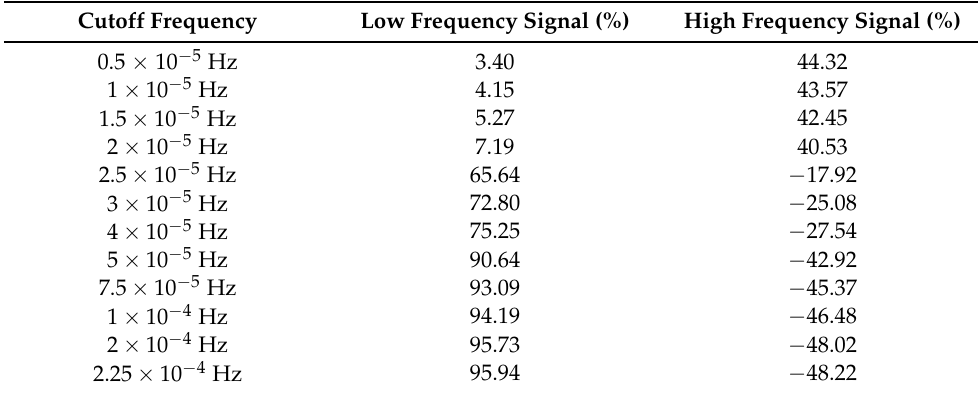
Figure 5. R 2 Score versus Cutoff Frequency used for decomposing the data signal. Table 1. R 2 Score versus Cutoff